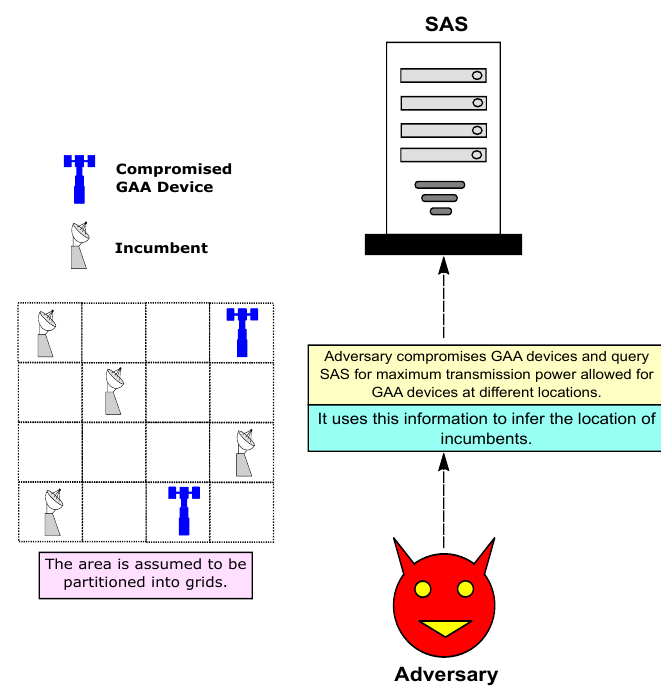
Figure 7. Adversary infers the location of the